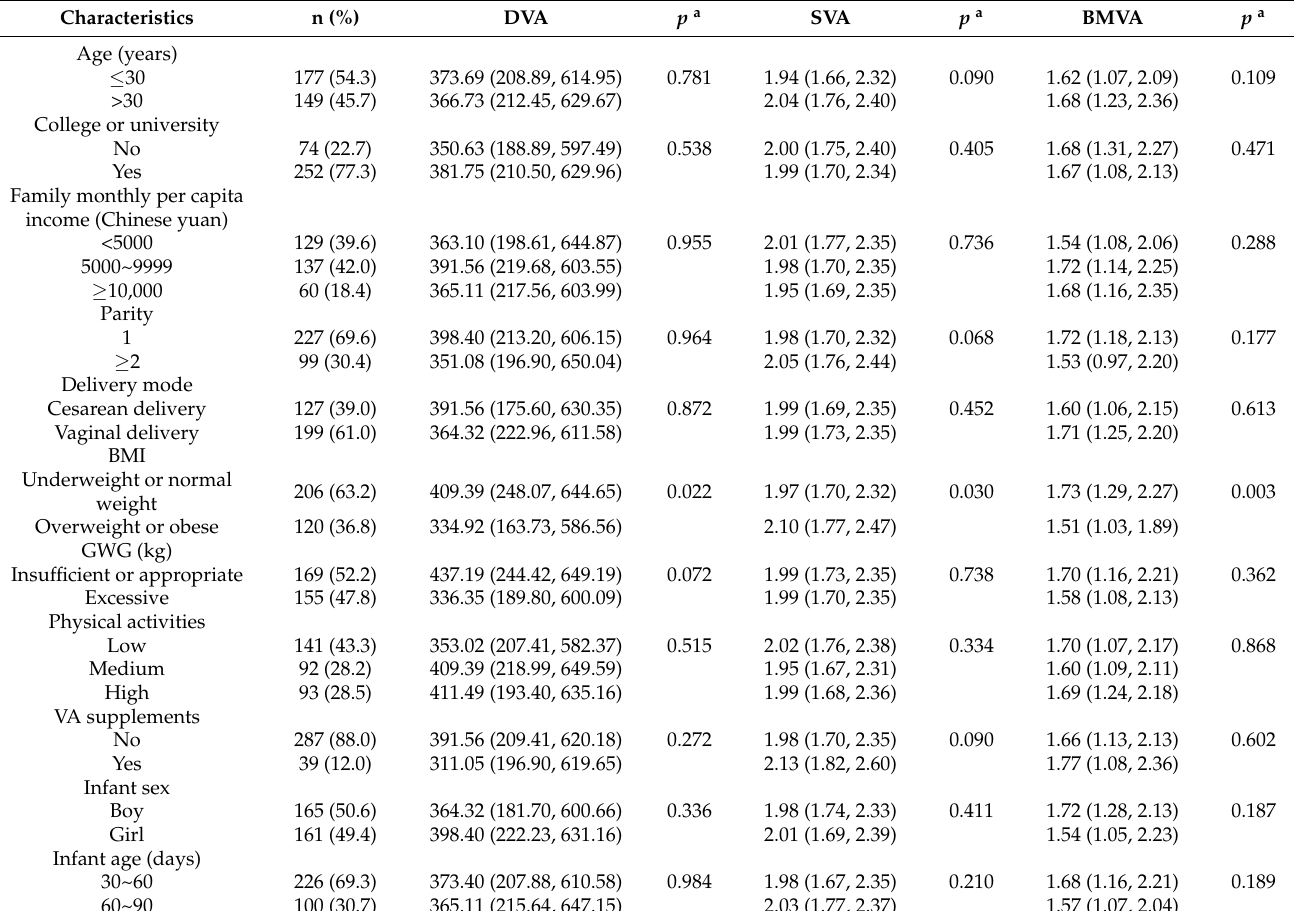
Table 1. DVA [ µ g RAE/day, median (25th, 75th)], SVA [ µ mol/L, median (25th, 75th)] and BMVA [ µ mol/L, median (25th, 75th)] among lactating women with different